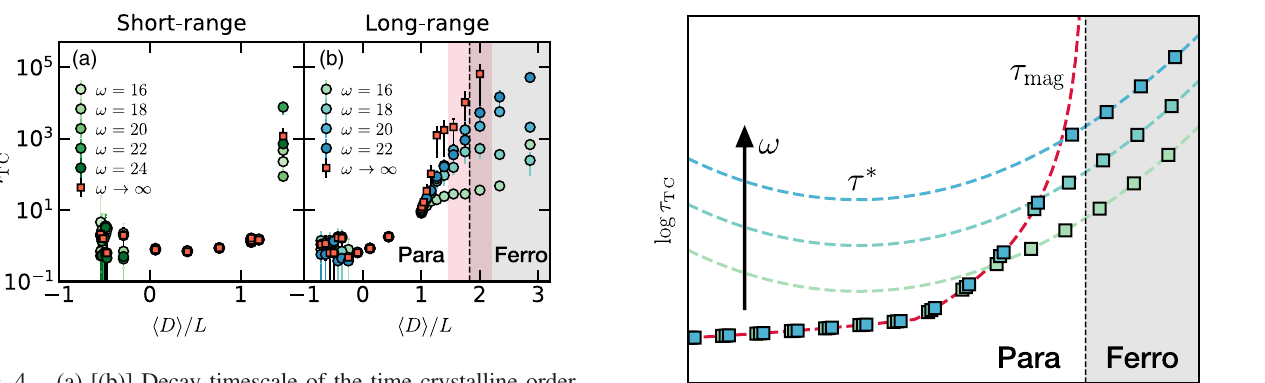
FIG. 4. (a) [(b)] Decay timescale of the time crystalline order parameter τ as a function of the energy density of the initial TC state for the short- [long-]range model. In the short-range model FIG. 5. Schematic explanation of the behavior near the tran- (a), τ is fast, independent of frequency, and in agreement with TC sition of the long-range model (Fig. 4). There are two competing the decay timescale of the magnetization M ð t Þ if the system were timescales: the heating time τ (cid:2) and the magnetization decay time evolved according to D alone (red squares). In the long-range τ of the prethermal Hamiltonian D (cid:2) [captured by the red model (b), an analogous behavior occurs near the center of the mag spectrum. However, as one moves to higher energies across the squares in Figs. 4(a) and 4(b)]. As the system approaches the paramagnetic to ferromagnetic phase transition (red shaded phase transition into the ferromagnetic phase (shaded region) region), τ becomes exponentially dependent on the frequency from the paramagnetic side, τ diverges (red dashed line). The TC mag of the drive and τ approaches τ (cid:2) . In this regime, τ is set by the relaxation time τ is given by the smaller of these two time- TC TC TC exponentially slow heating rather than the prethermal dynamics scales. In (most of) the paramagnetic phase, τ is smaller and mag for all frequencies — the prethermal time crystal is approximately frequency independent; while in the ferromagnetic phase, τ (cid:2) is smaller; τ shares its strong frequency dependence. TC